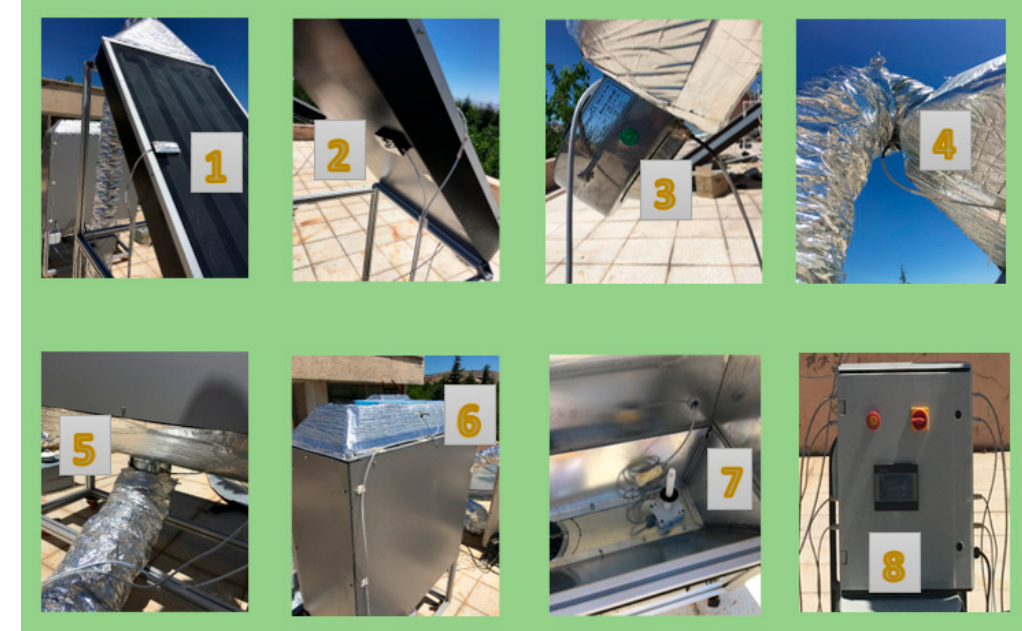
Figure 2. The measuring points: (1) Panel glass temperature; (2) panel floor temperature; (3) panel inlet temperature; (4) panel outlet temperature; (5) drying cabinet inlet temperature; (6) drying cabinet outlet temperature; (7) drying cabinet temperature; (8) measurement monitoring screen.